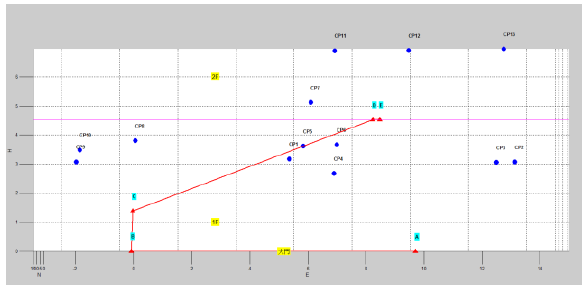
Figure 11(b). Distribution of the control point (Side view).